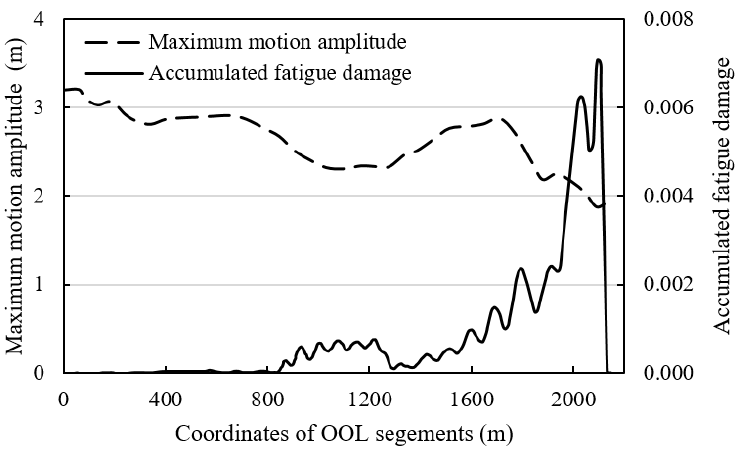
Figure 10. Motion amplitude and fatigue damage distribution along the length of